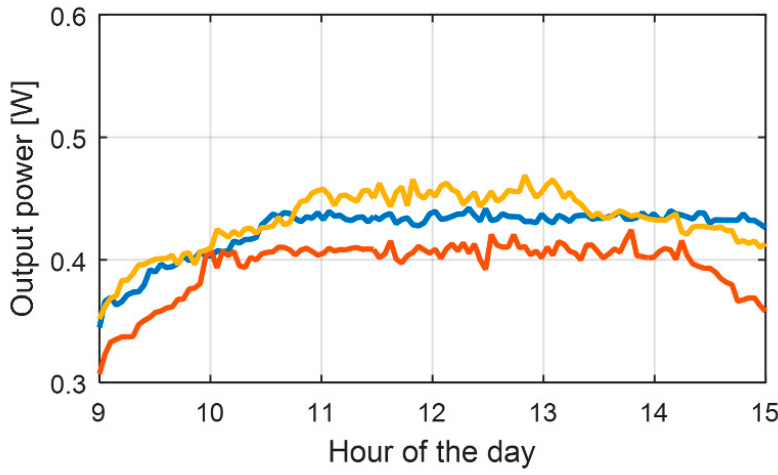
Figure 24. Output power for days with low radiation.